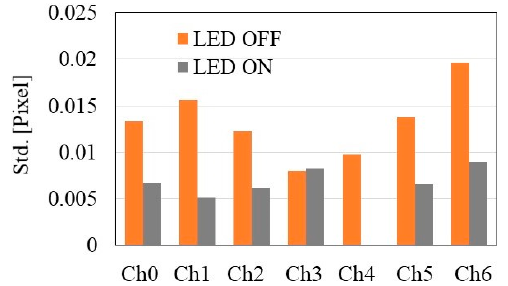
Figure 18. Difference in measurement accuracy due to turning the LED light on and off (standard deviation of contact type and non-marker image measurement responses).